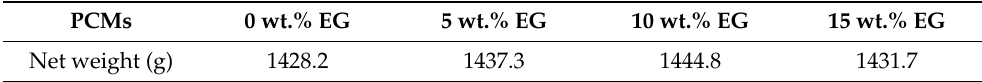
Table 2. Net weight of PCM in 4 heat reservoirs.